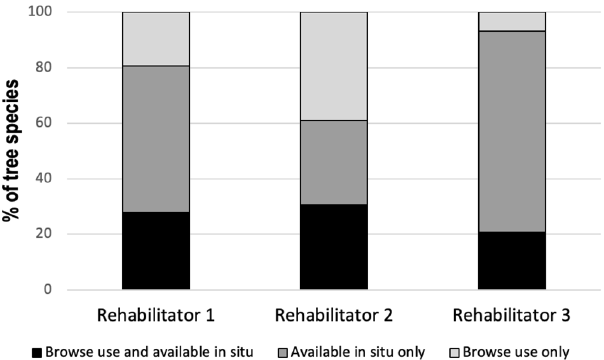
Figure 7. Comparison of the percentage of tree species used for browse collection that were also available to koalas in situ, versus those that were available to koalas in situ but not used for browse, and those that were used for browse but not available to koalas in